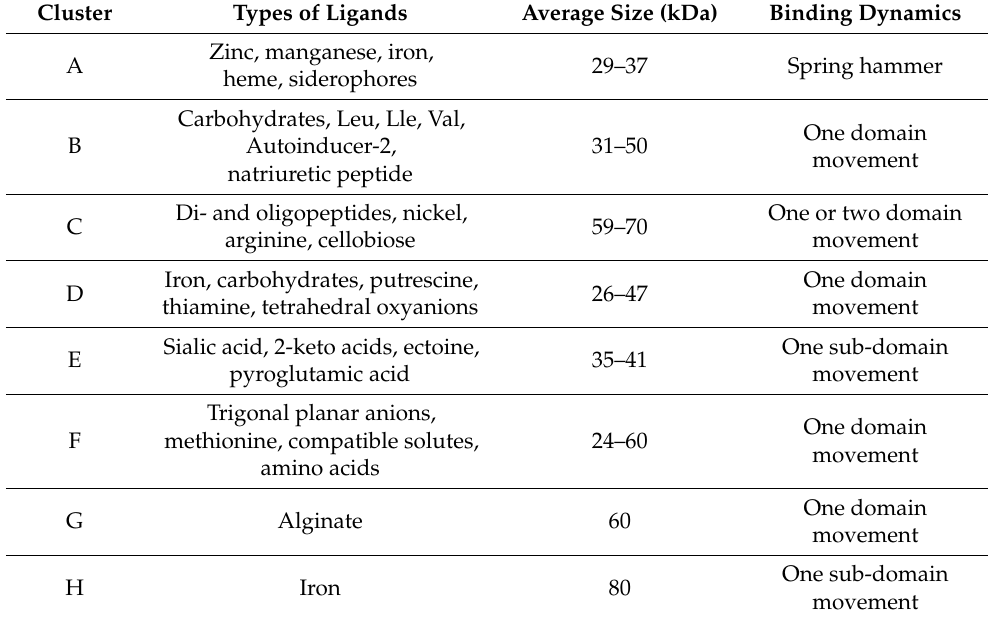
Table 1. Summary of substrate binding protein clusters.